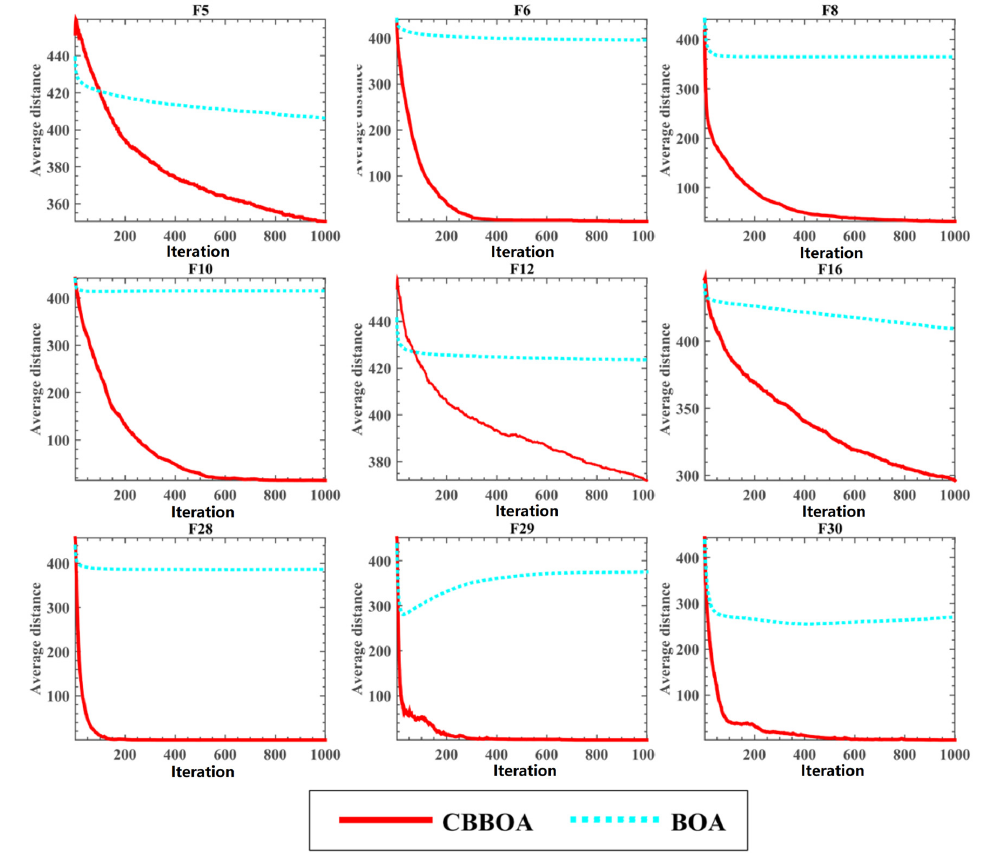
Figure 7. Diversity analysis of CBBOA and BOA. Table 2. Classification results of CBBOA-SVM-FS in the light of four